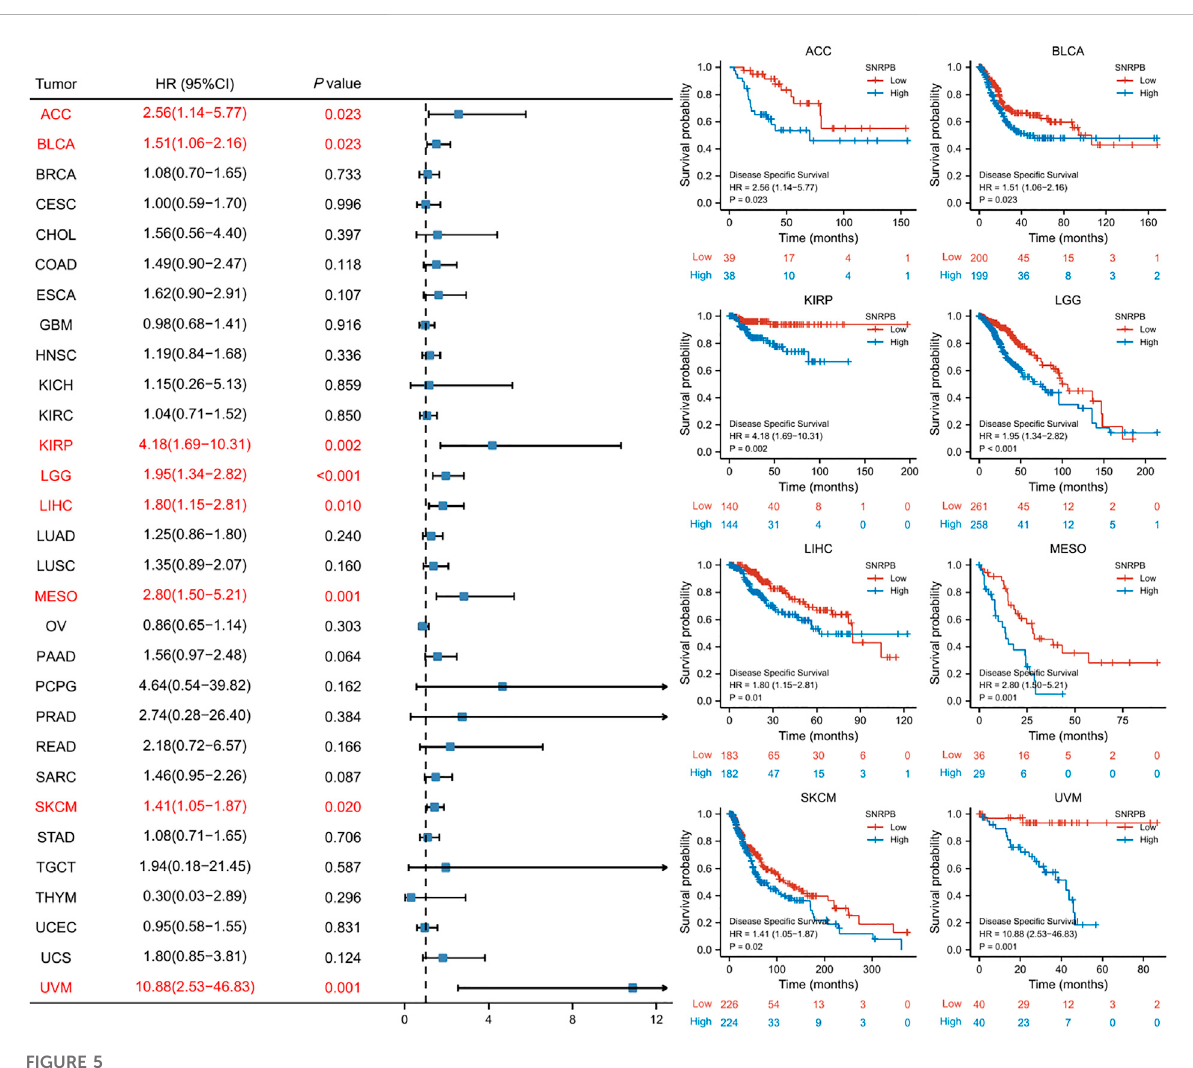
FIGURE 5 The relationship between SNRPB expression and DSS across